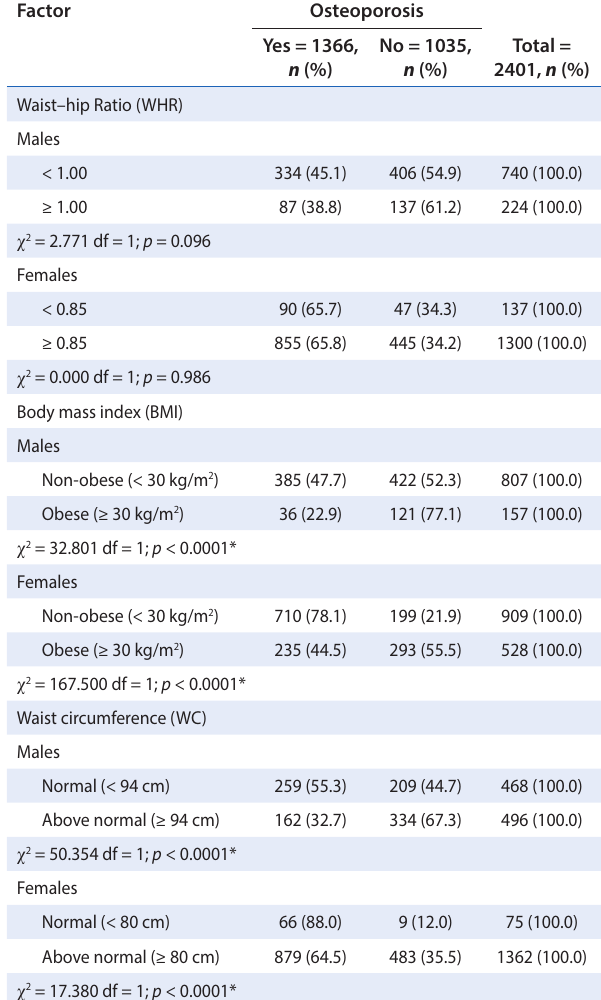
*Significant at 5% level of